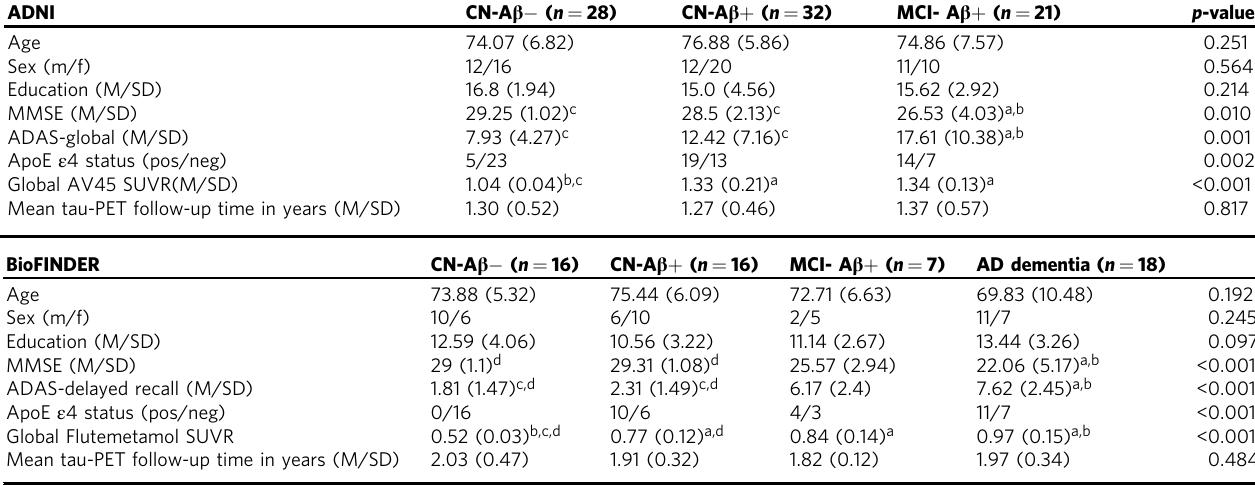
p-values were derived from ANOVA for continuous measures and from Chi-squared tests for categorical measures M male, f female, MMSE Mini-Mental State Exam, ADAS Alzheimer ’ s disease assessment scale, cognitive subscale Mean values signi fi cantly (p<0.05) different from — a CN-A β − b CN-A β + c MCI-A β +